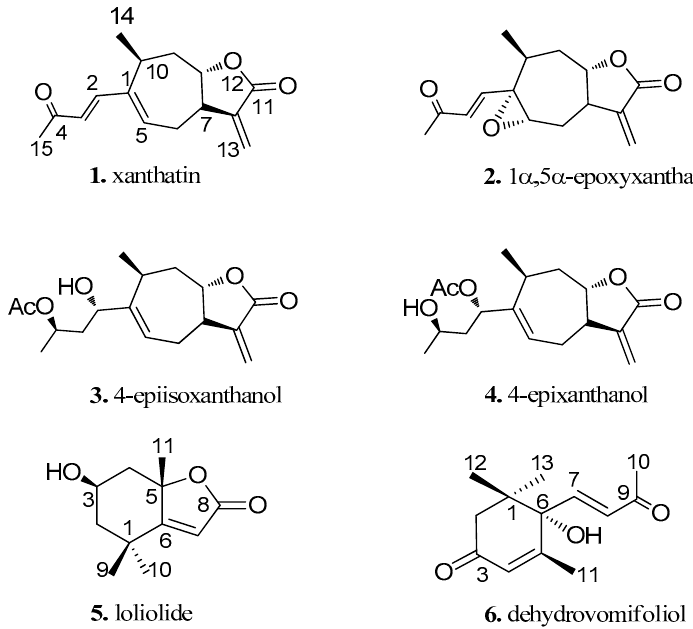
Figure 1. Chemical structures of 1 – 6 .